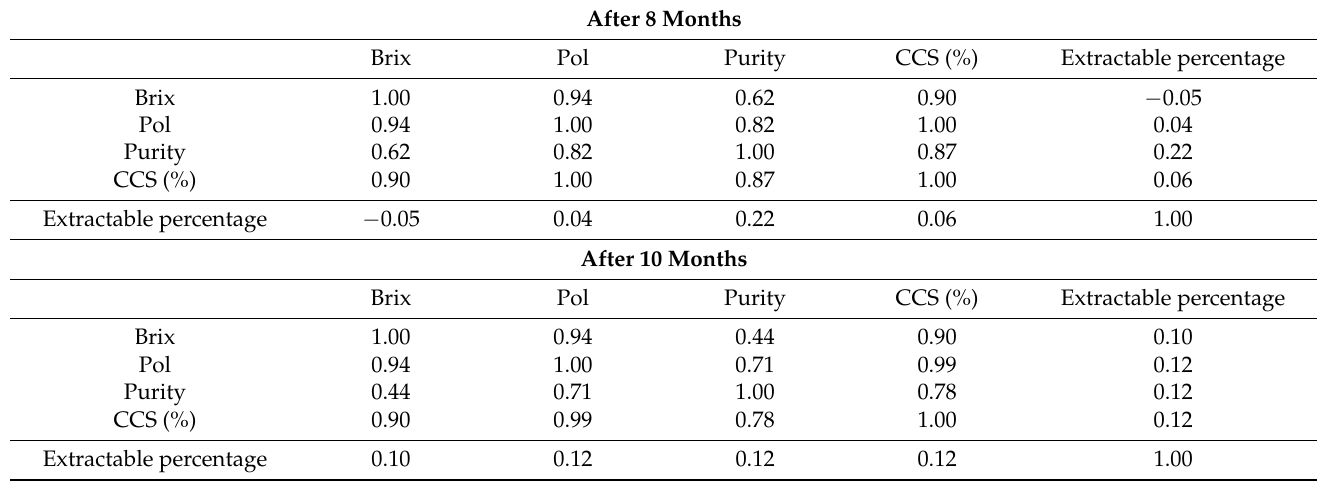
Table 6. Correlation analysis between different quality parameters of sugarcane 8 and 10 months after harvesting the initial crop plant. After 8 Months Brix Pol Purity CCS (%) Extractable